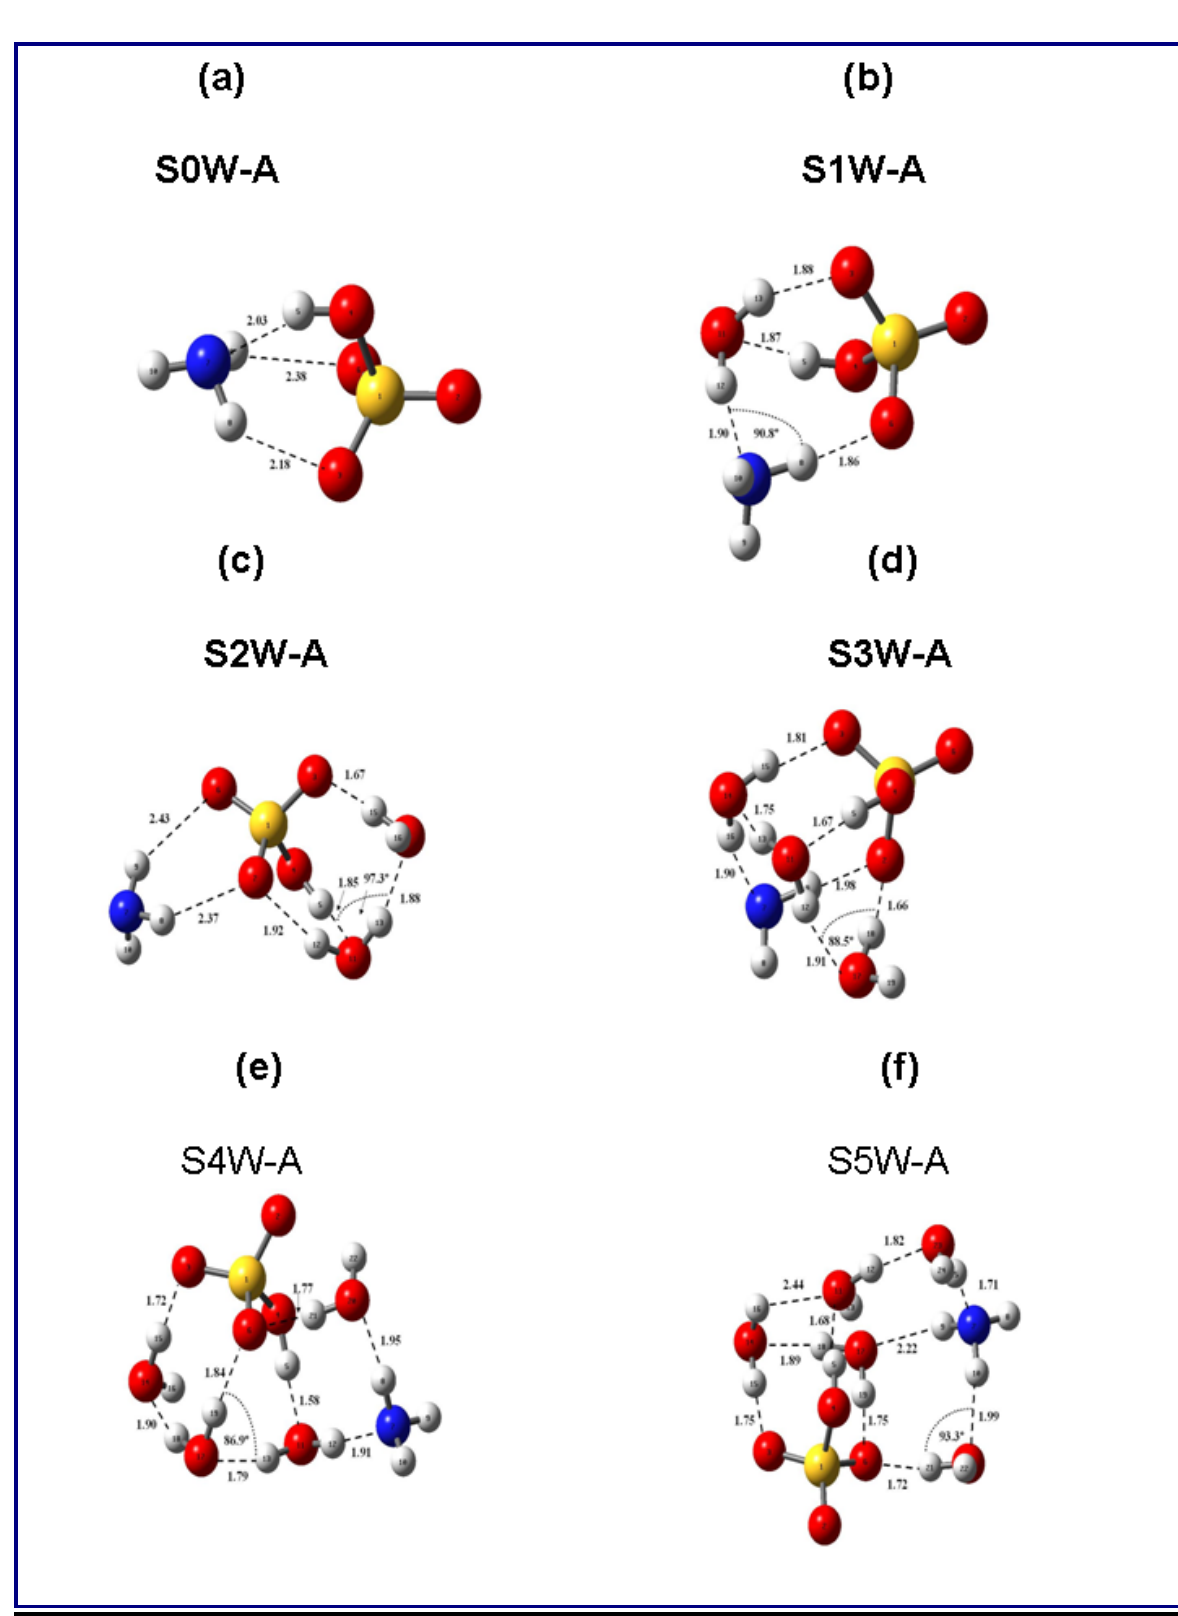
Figure 1. Most stable isomers of (a) (HSO 4- )(NH (c) (HSO 4- )(NH (f) (HSO 4- )(NH